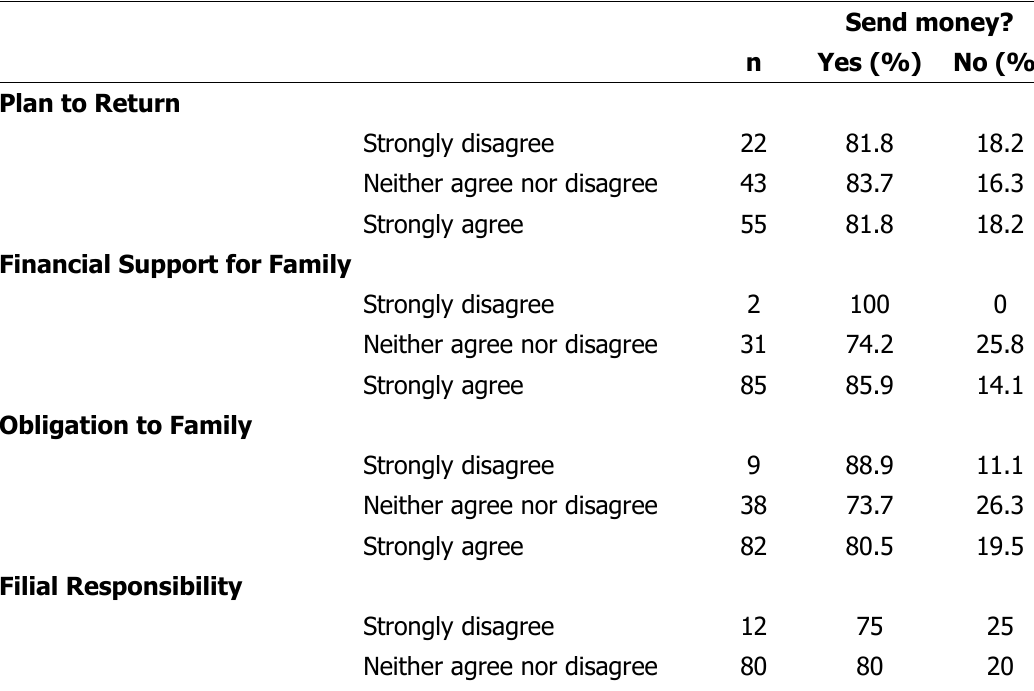
Table 5. Cross tabulations of factors with sending